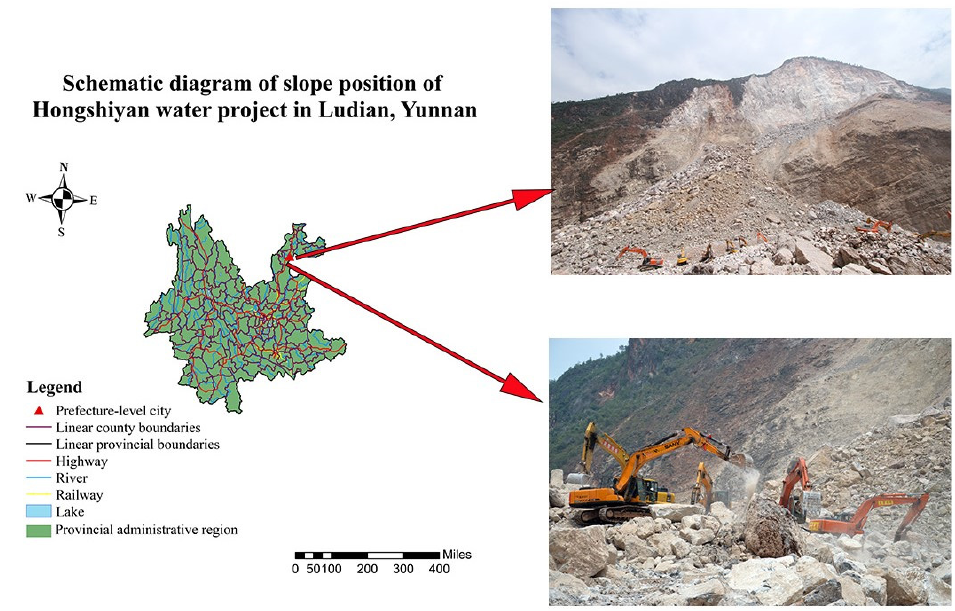
Figure 2. The location of the slope of the Hongshiyan water project.